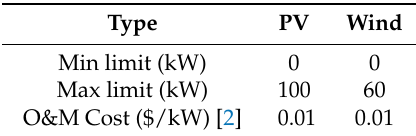
Table 2. Parameters of